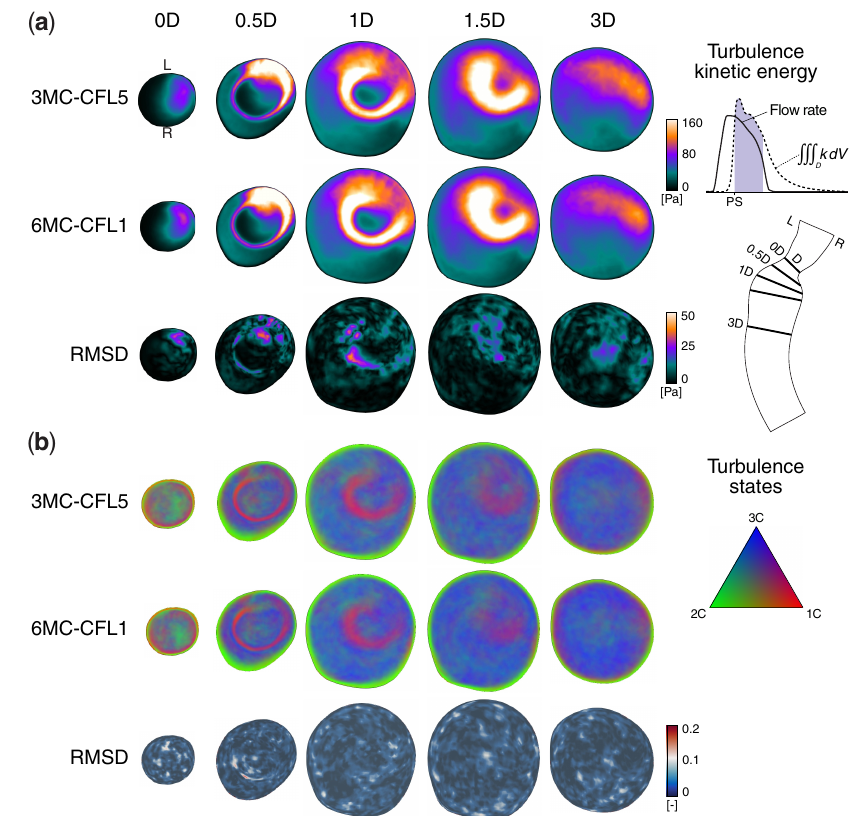
Figure 4. Spatiotemporal resolution effects on the time-averaged Reynolds stress characteristics in the post-stenotic region, evaluated by ( a ) turbulence kinetic energy ( k ) and ( b ) turbulence stress-states. The temporal mean of the results were considered over the EFD phase of the cardiac cycle (inset, shaded area). The mean RMSD errors are given in Figure 3 (EFD, green bars). Additional details are given in Figure